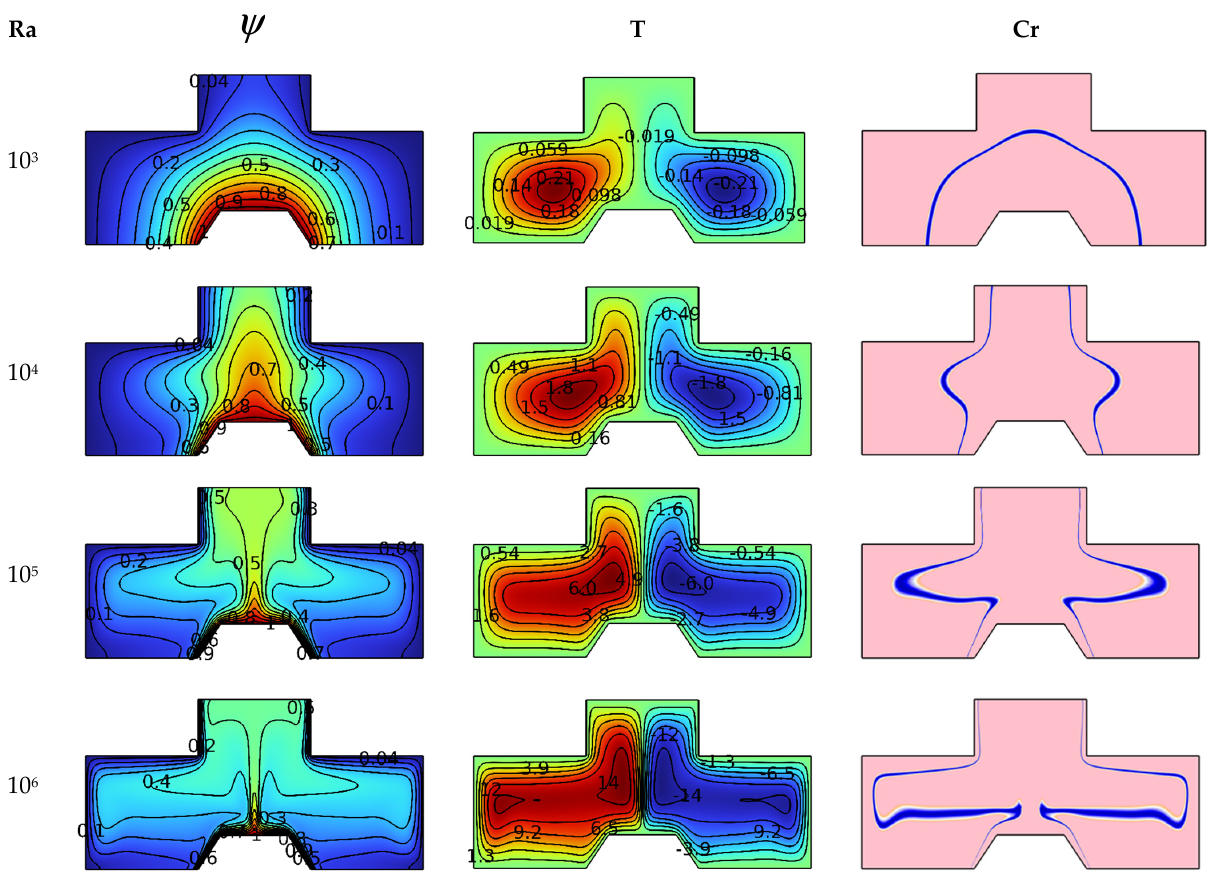
Figure 3. Ra number influence on streamlines, isotherms, and Cr for Da = 10 − 2 , Ha = 0, and ϕ = 4%. When Ra = 10 6 , the intensity of thermal buoyancy becomes very high, and we notice that the center of the vortex is divided into two parts, the first near the cold wall and the second near the hot fin. For the heat capacity contours (Cr), we notice an effect of the number Ra on the heat capacity (Cr). We notice that there is a line in the form of a semicircle around the trapezoidal fin for Ra = 10 3 , then it is divided into two symmetric parts as the number Ra increases. The blue lines indicate the regions where the change of physical state occurs for PCM nanoparticles. We notice that the lines expand in terms of Ra because the movement of suspension particles increases in terms of Ra. In addition to this, it is noticed that the two heat capacity lines are thinner, close to both cold and hot walls, while they are thicker in the middle of the room. The greater the temperature gradient, the thinner